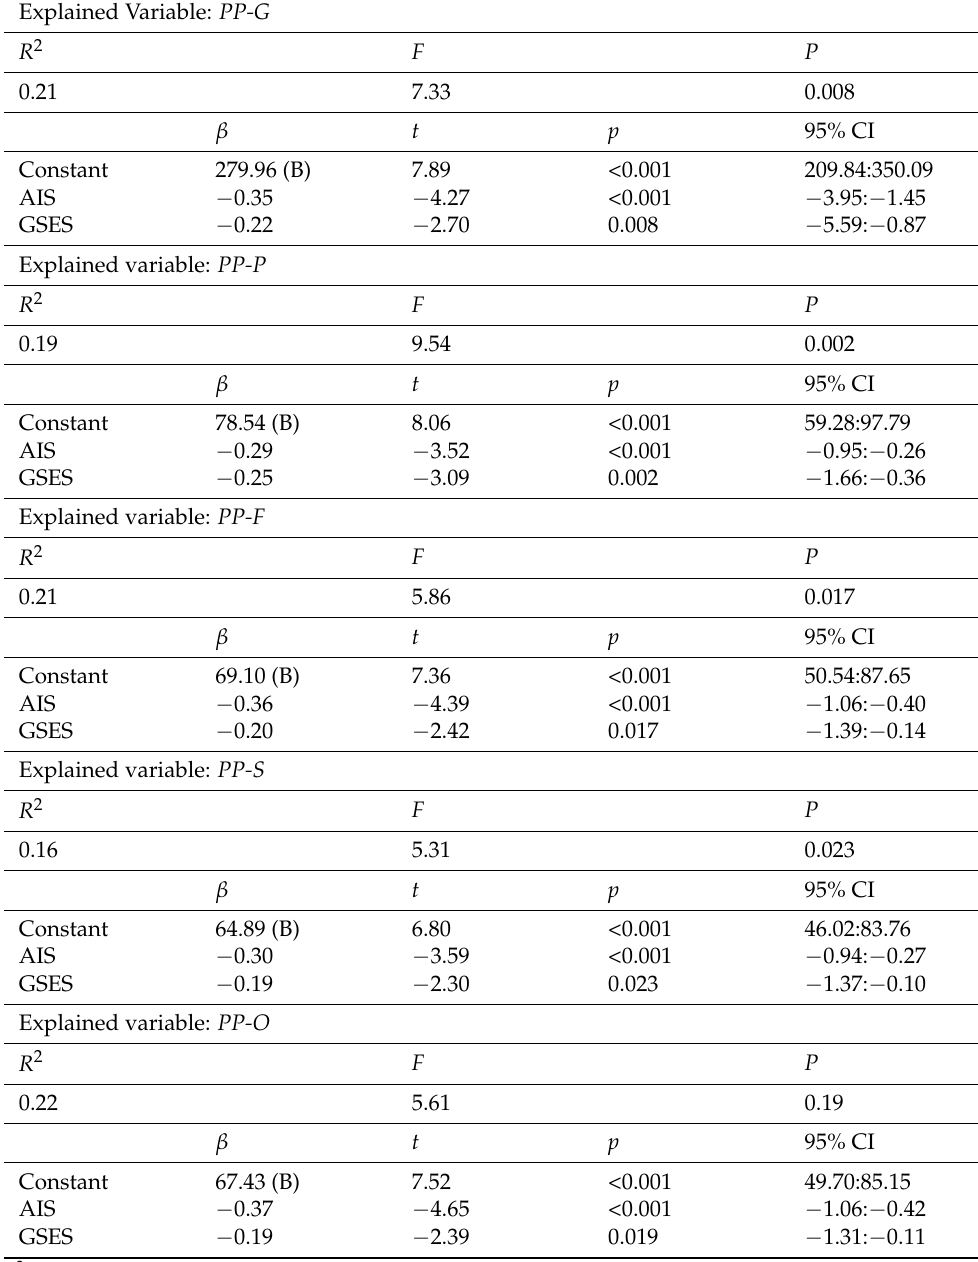
Table 4. Predictors of psychosocial problems—the E